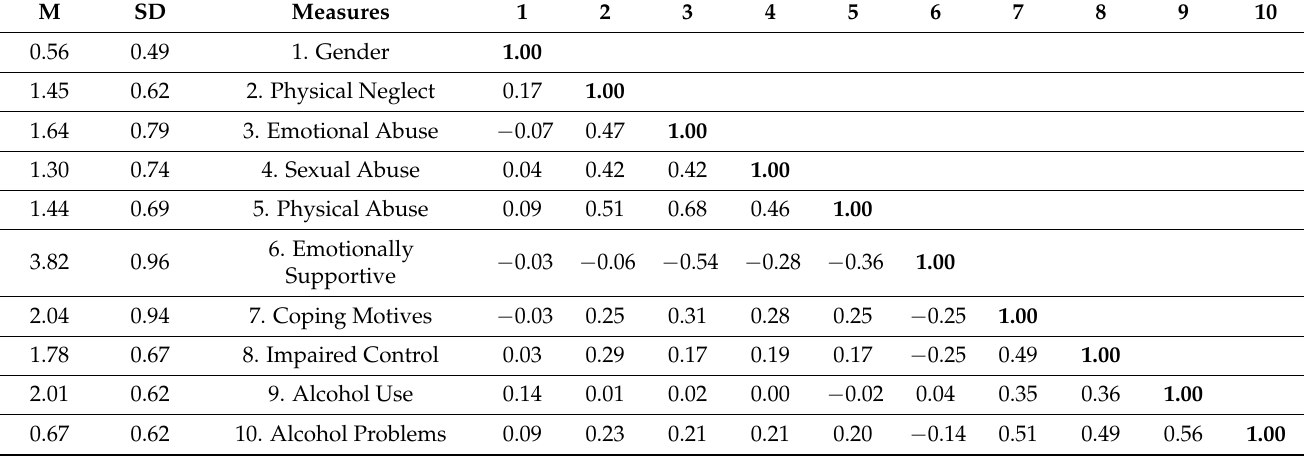
Table 1. Means, standard deviations, and correlations among all variables in the path model.